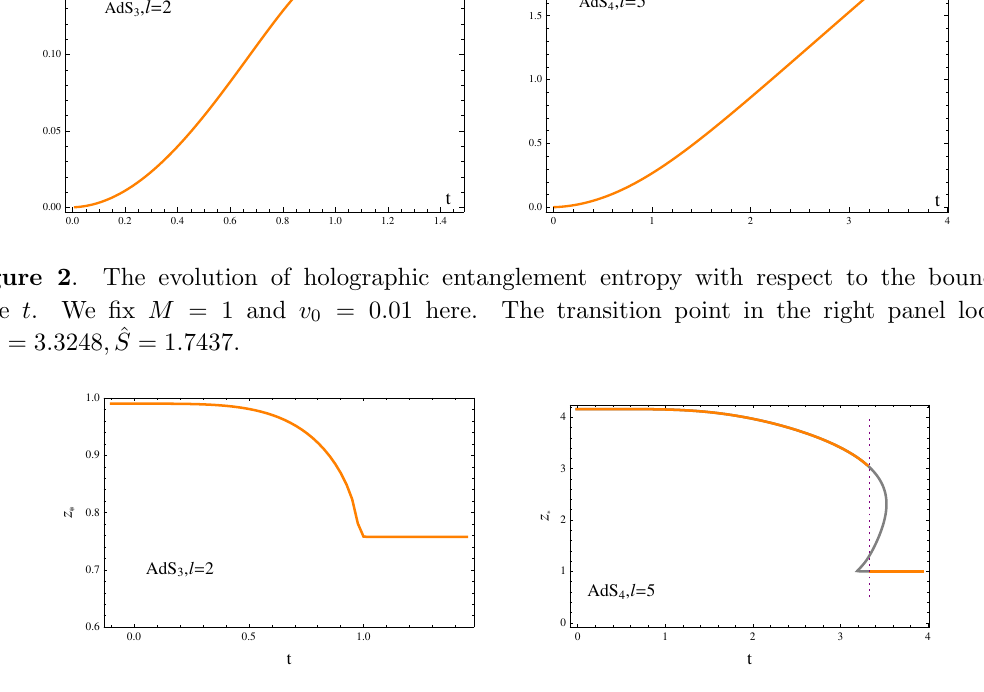
Figure 3 . The evolution of z (cid:3) with respect to boundary time t . We (cid:12)x M = 1 and v 0 = 0 : 01 here. The orange parts correspond to the surfaces of the minimum area. The transition point locates at t = 3 : 3248 in the right